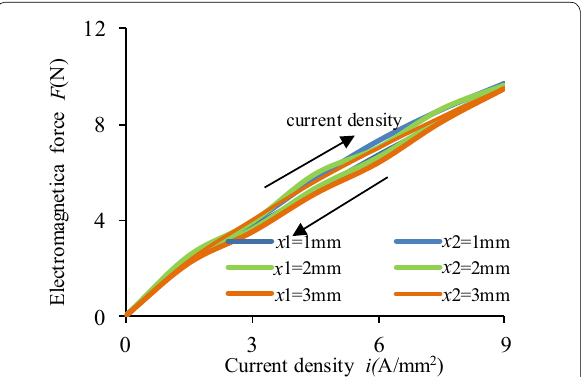
Figure 11 Current density-pull force hysteresis of the inner rod